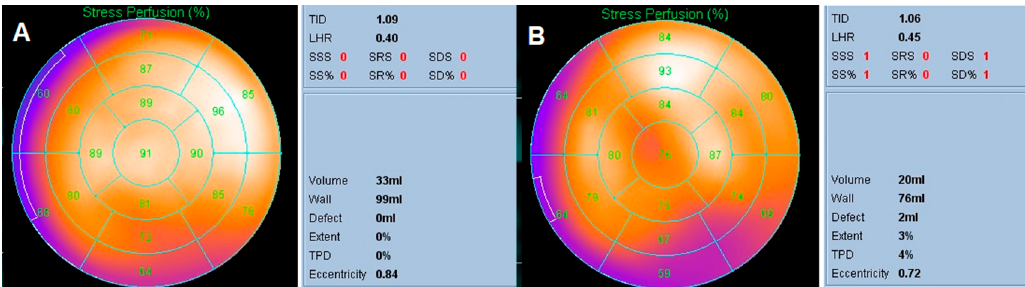
Figure 1. Demonstration of semi-quantitative parameters from myocardial perfusion imaging after analysis of image reconstruction. ( A ) The myocardial perfusion imaging (MPI) of a 64-year-old man who suffered from atypical chest pain. The bull’s eye revealed nearly normal perfusion on the stress phase image, with a stress total perfusion deficit (sTPD) of 0%. His cardiac catheterization one week later disclosed no significant stenosis in the 3 coronary arteries. ( B ) The MPI of a 75-year-old woman who suffered from chest pain for a period of time. The bull’s eye revealed decreased perfusion in the proximal inferior and proximal to mid-inferolateral walls of the left ventricle. The sTPD was 4%. Other parameters such as transient ischemic dilation (TID), lung-to-heart ratio (LHR), summed stress score (SSS), summed rest score (SRS) and summed difference score (SDS) were also observed. Her cardiac catheterization two weeks later disclosed a 70% stenosis in Seg 1 of the right coronary artery. SS: summed stress; SR: summed rest; SD: summed difference.